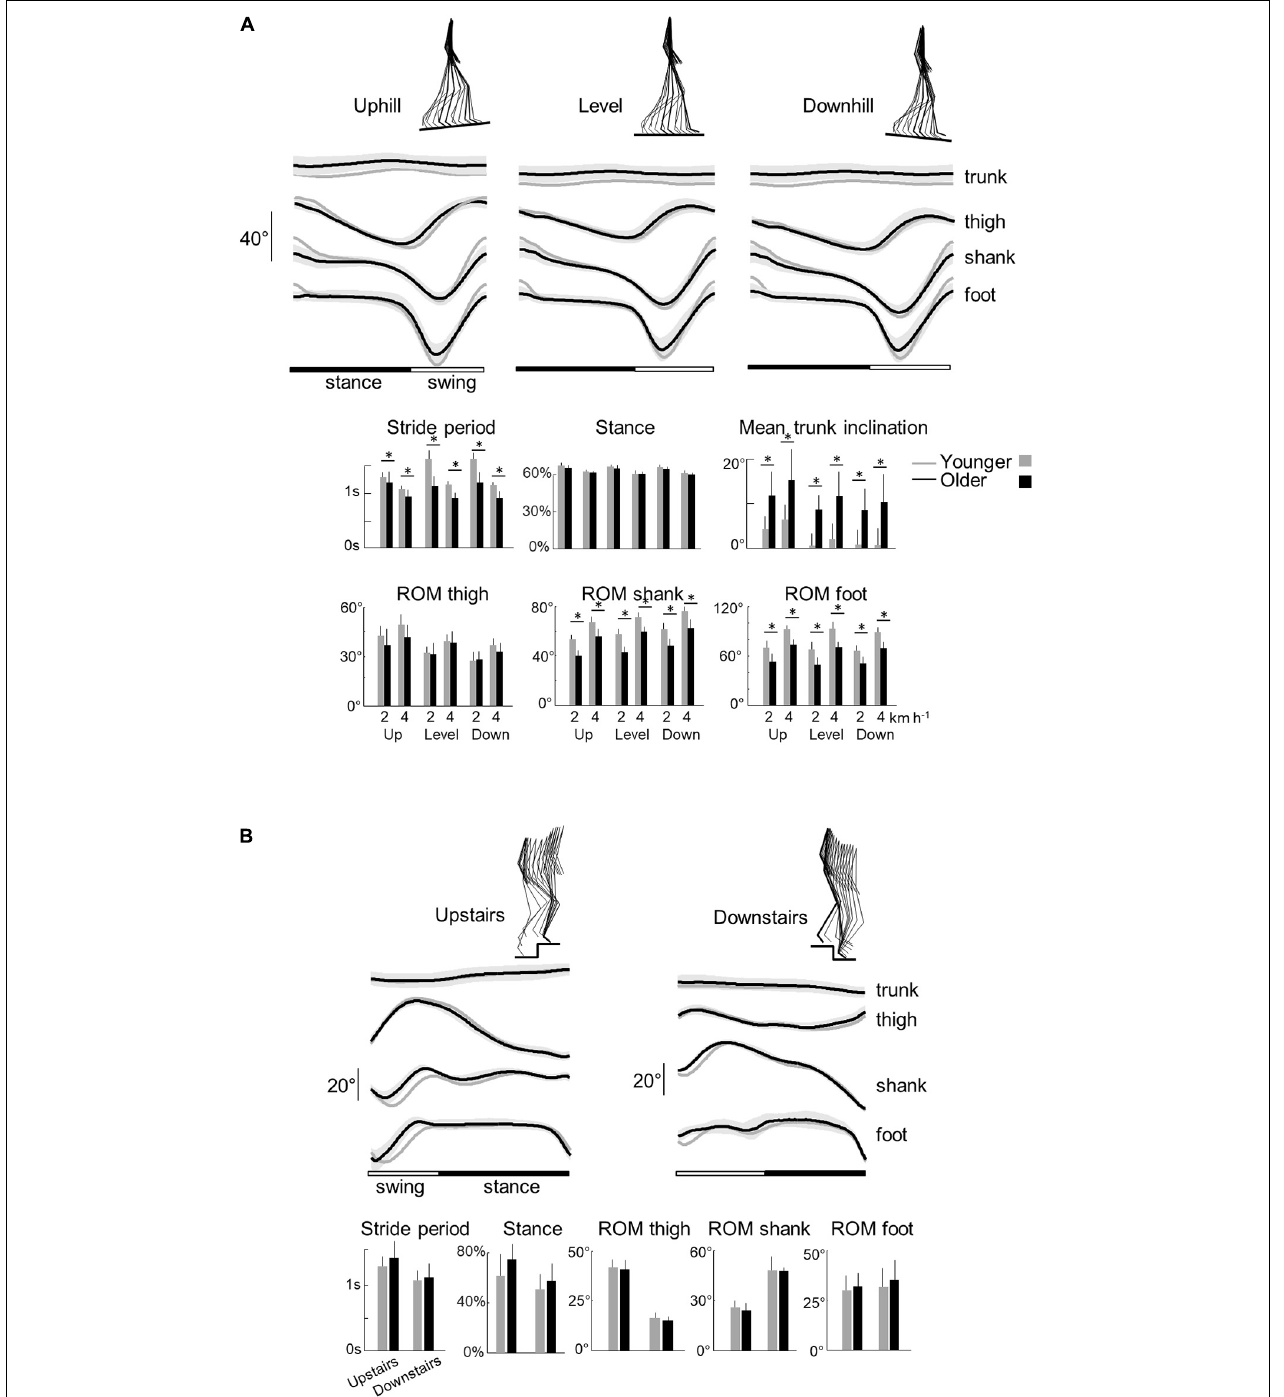
FIGURE 2 | Elevation angles of lower-limb segments and general gait parameters across all conditions in younger and older adults. (A) Walking tasks: elevation angles of the trunk, thigh, shank, and foot over a stride. All the curves of each subject walking at a given walking condition were first averaged (mean-curve). The curves presented here are the average of the mean-curves of all the young (gray lines) and older (black lines) adults. The gray zone represents ± 1 SD for the older adults. Below, the bar plots present the average stride period, relative stance phase, and mean trunk inclination over one stride, as well as the average range of motion of the thigh, shank, and foot over one stride. Bars are presented for each walking task and at each speed (2 and 4 indicate the speed in km h − 1 ). (B) Stair stepping tasks: elevation angles of the trunk, thigh, shank, and foot over a stride. Below, the bar plots present the average stride period, relative stance phase, and the average range of motion of the thigh, shank, and foot over one stride. In all panels, gray bars correspond to young adults, whereas black bars correspond to elderly adults. Thin lines represent one standard deviation. The * indicates a significant effect of age (Student t -test, p < 0.05).